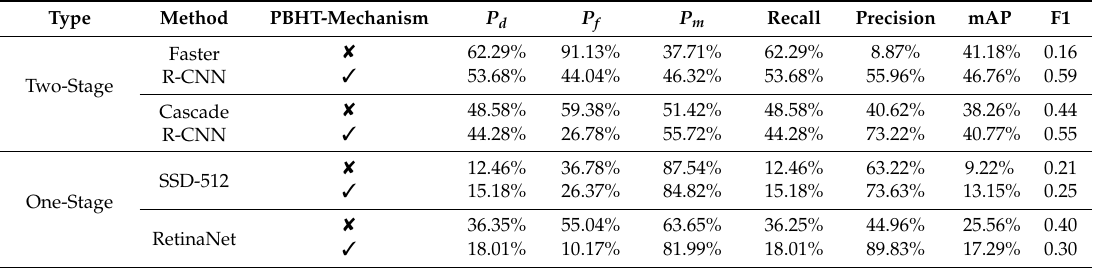
Table 14. Detection performance with and without PBHT-mechanism on the inshore scenes.